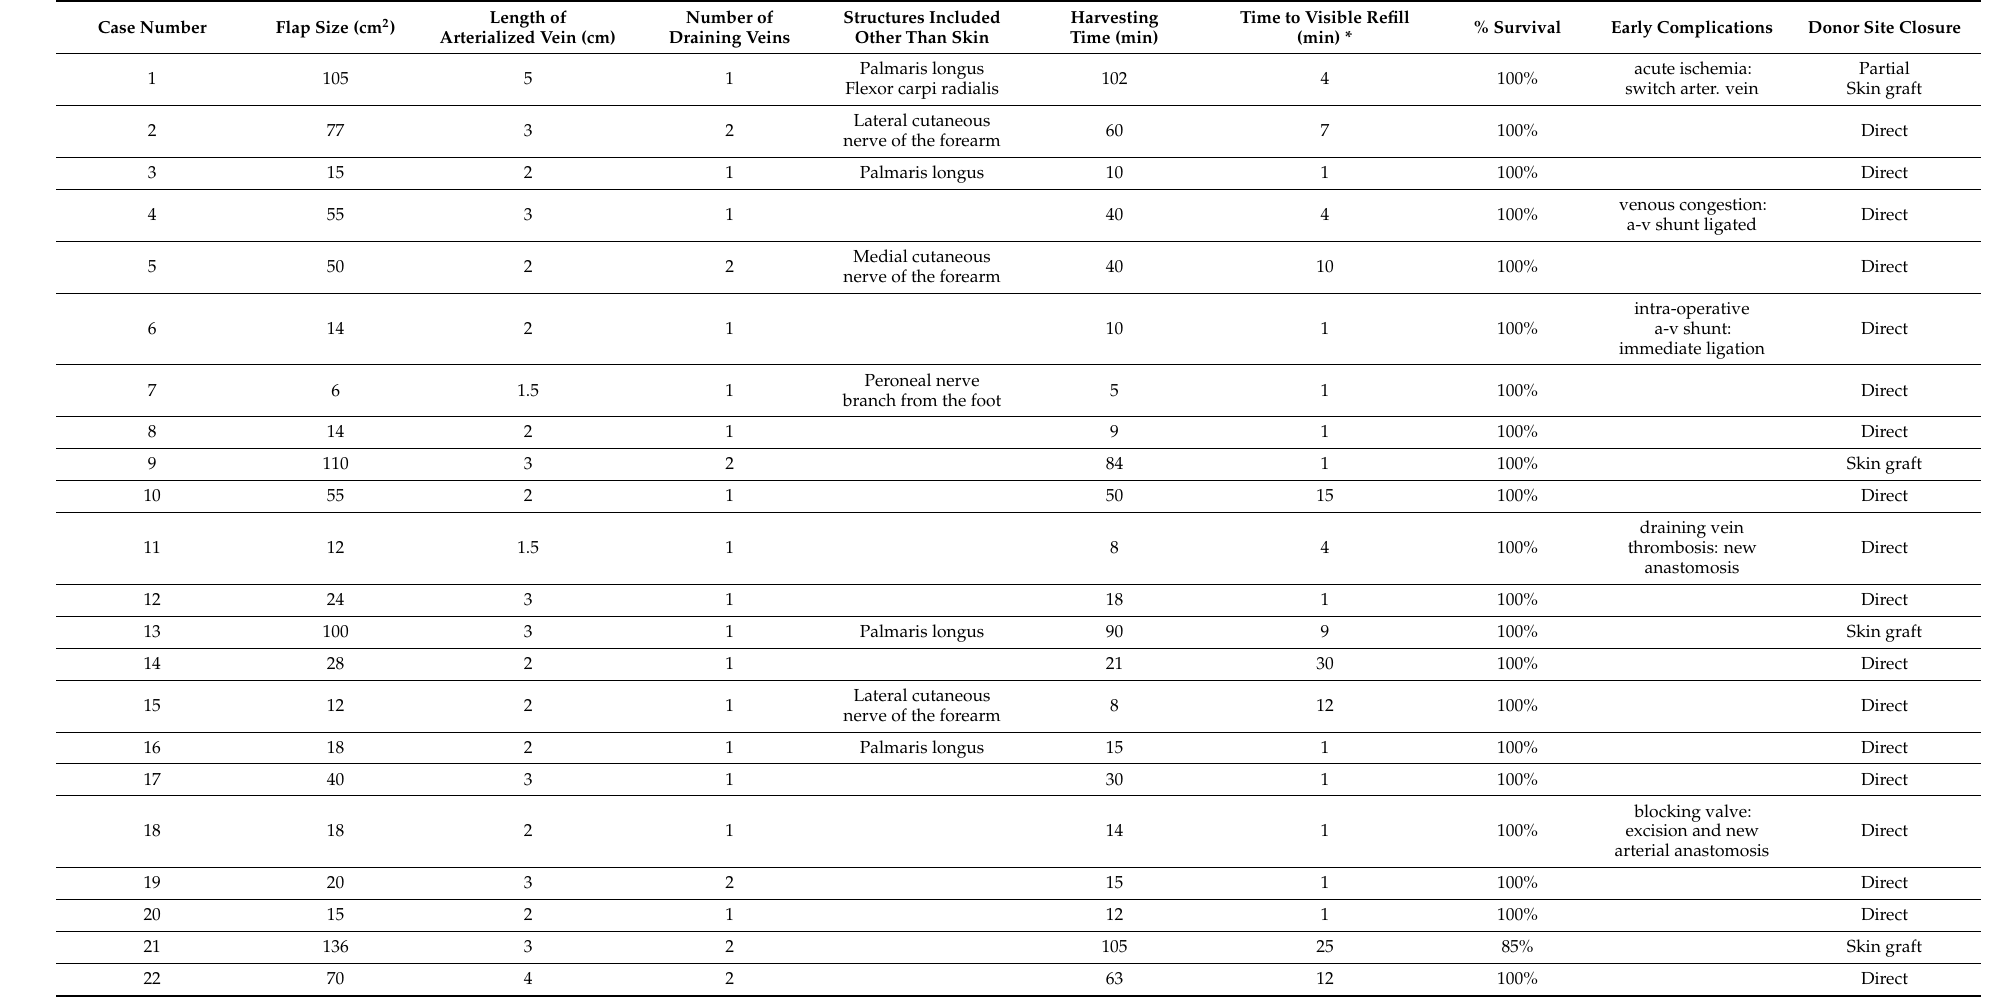
Table 2. Technical details of the flaps. * In all flaps with a visible refill under the minute, the time was considered as one